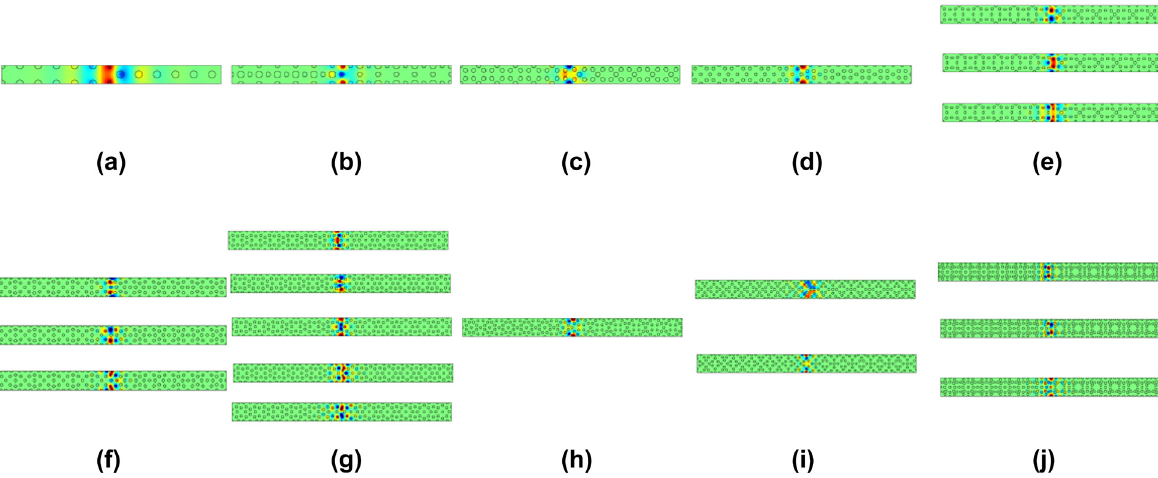
Figure A2: Eigenfielddistributions of edge states ( k || = 0) for the supercells consisting of (a) UC1Aand UC1B, (b) UC3A andUC3B, (c) UC5A and UC5B, (d) UC7A and UC7B, (e) UC9A and UC9B, (f) UC11A and UC11B, (g) UC13A and UC13B, (h) UC15A and UC15B, (i) UC17A and UC17B, and (j) UC19A and